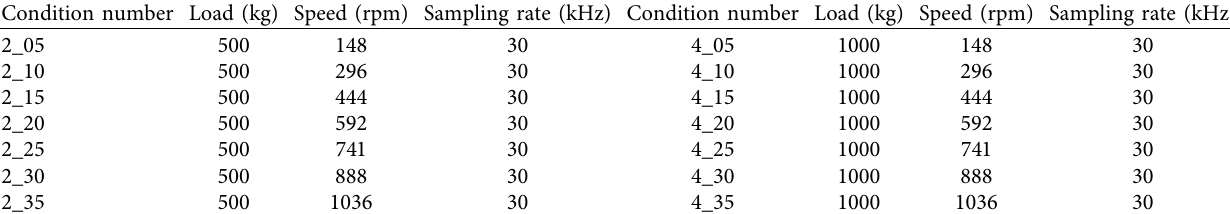
Table 4: Description of load and speed conditions.